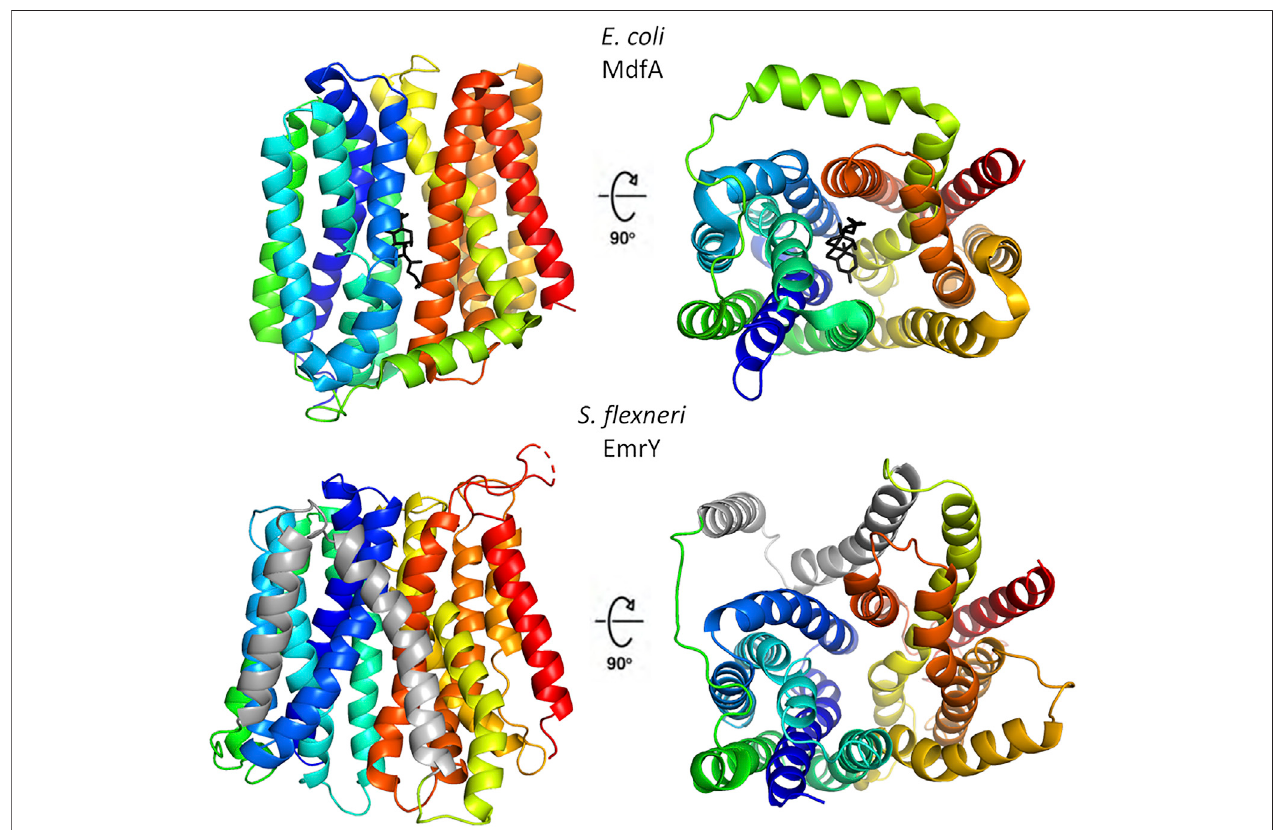
FIGURE 2 | Structural organization of representative multidrug resistance MFS transporters of the DHA1 and DHA2 families. The upper panels show the 12-TM structureof E.coli MdfAintheinward openconformation(PDB4zp0); intherightpaneltheprotein isrotatedby90 ° toevidencetheentrancetocentralcavitywithbound chloramphenicol(black),theviewisfromthecytosolicside.Thelowerpanelsdepictthe14-TMhomologymodelof S. fl exneri EmrYintheinwardopenconformation;the proteinisshowninthesameorientationsofMdfAtofacilitatecomparison.ThetwoadditionalTMhelicesarecoloredingray.ThemodelwasobtainedattheSWISS- MODEL server (Waterhouse et al., 2018) using a POT transporter (PDB 4IKV) as template. The sequence of EmrY employed as query lacks residues 434 – 473, which correspond to the loop connecting TM13 and TM 14 (represented as a broken line). The fi gure was produced with